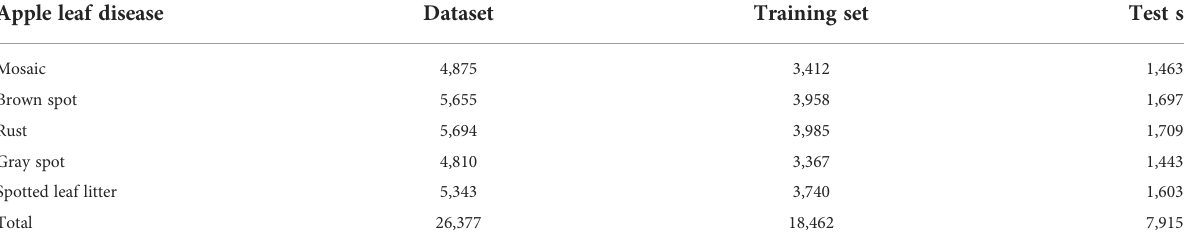
TABLE 2 Apple disease leaf image